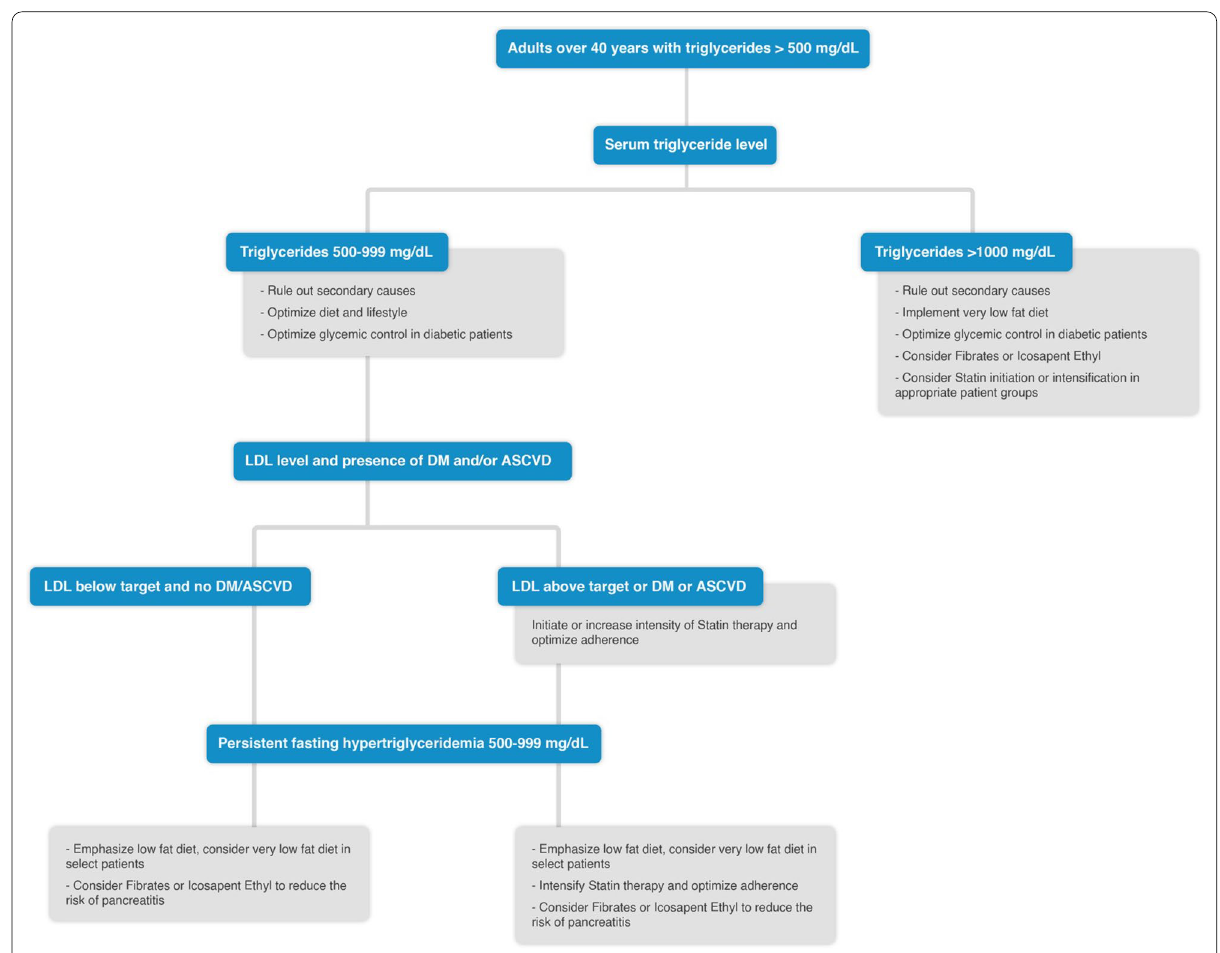
Fig. 2 Management of HTG